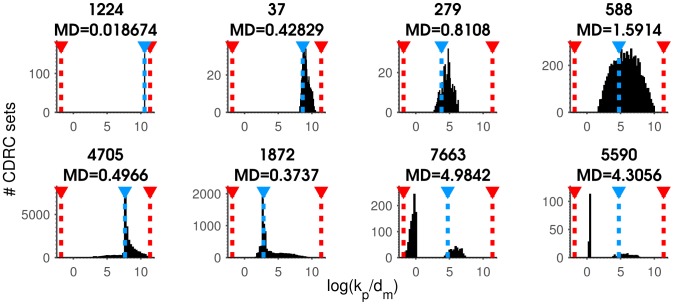
MD as a metric of fitness.Solution histograms for the CDRC ratio . Titles show the library input set number above, and the corresponding MD for the histogram below. (Top row) Increasing MD values typically correspond to increasing distribution widths. (Bottom row, left 2 panels) Poorly estimated ratios with misleadingly low MD values. (Bottom row, right 2 panels) Informative CDRC ratio histograms with misleadingly high MD values.